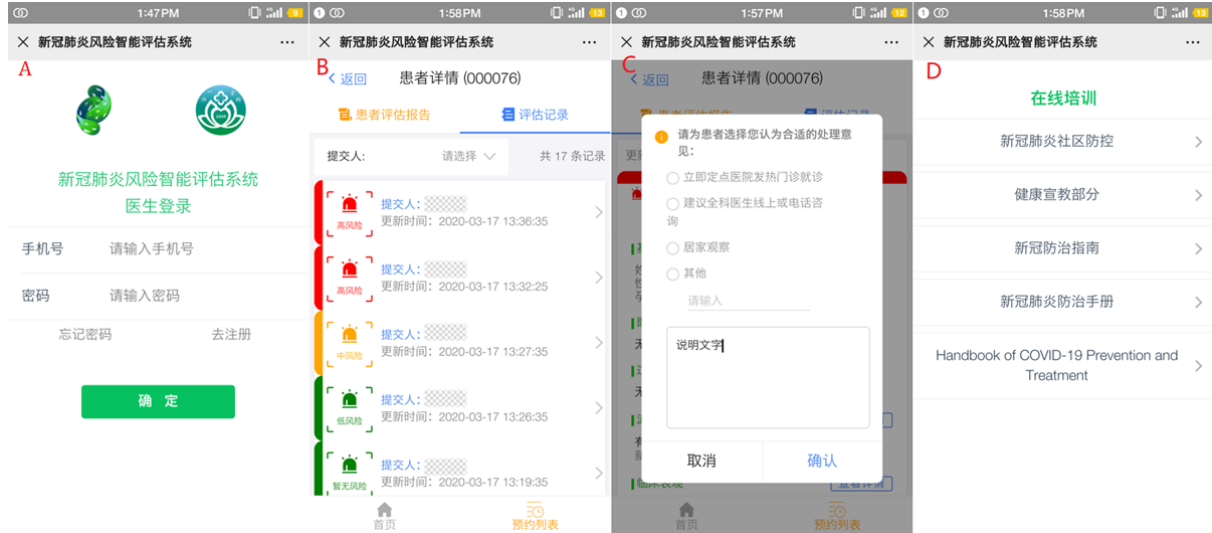
Figure 6. The screenshots of DDC19’s doctor mobile terminal